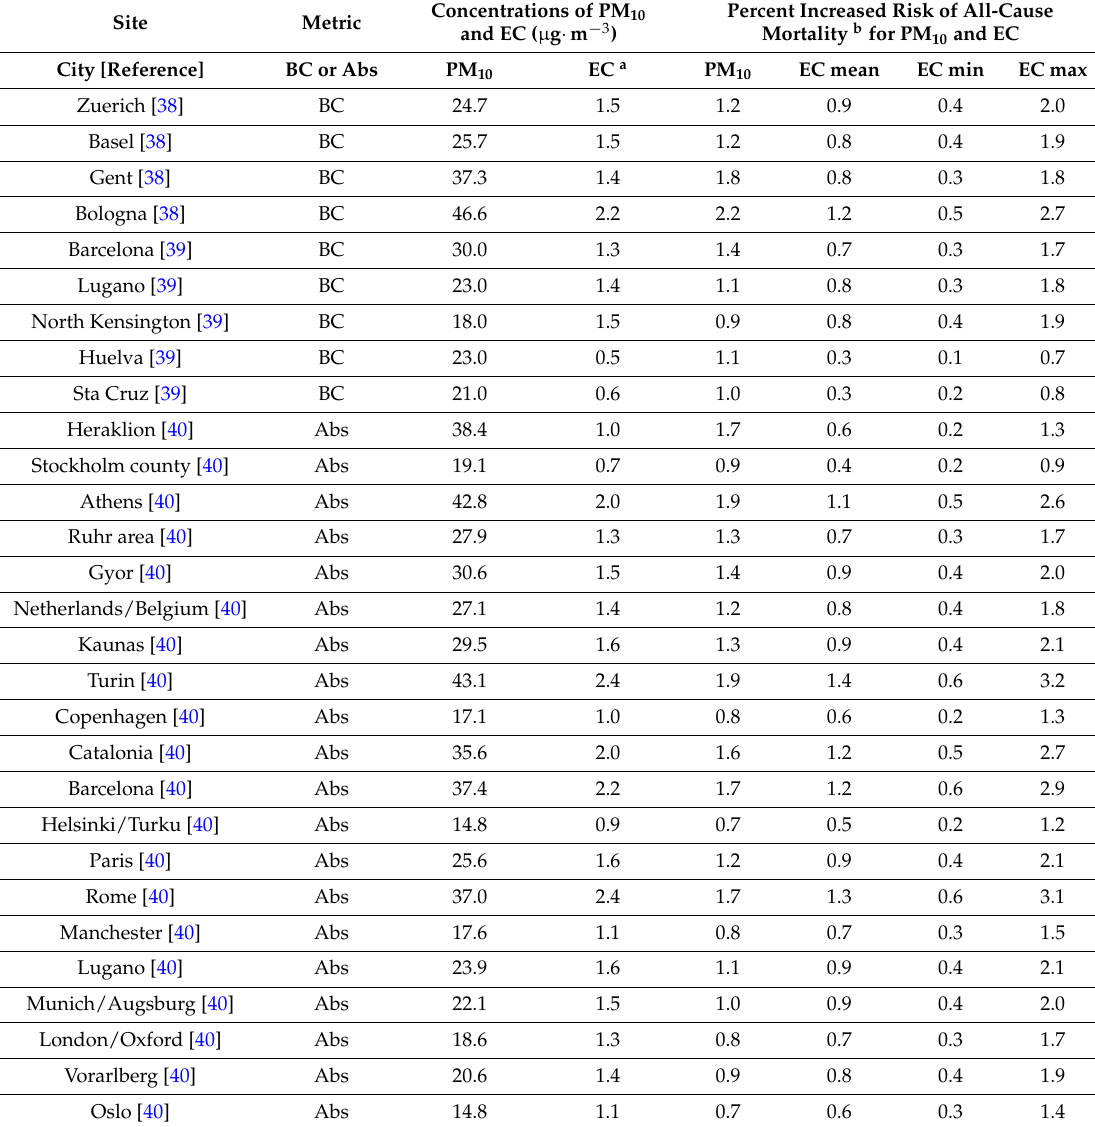
Table 2. Measured concentrations of PM 10 and EC, and the calculated percent increase in all-cause mortality related to short-term exposure in a number of urban background sites in